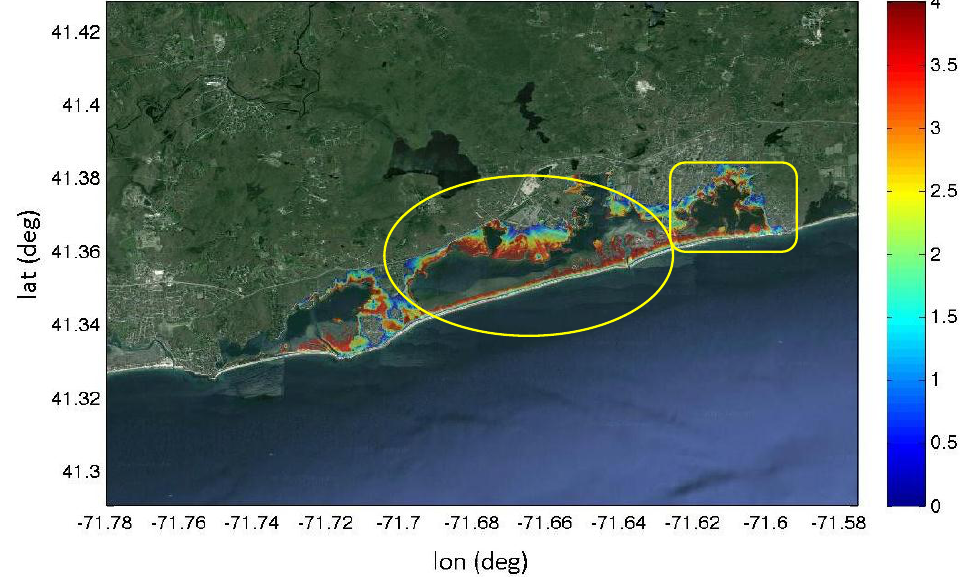
Figure 9. Inundation depths (m) relative to grade for Charlestown, RI for 100 year event [20]. Ninigret Pond is shown in the yellow oval and Green Hill Pond in the yellow box. The contour scale provided at the right of the figure is in meters.